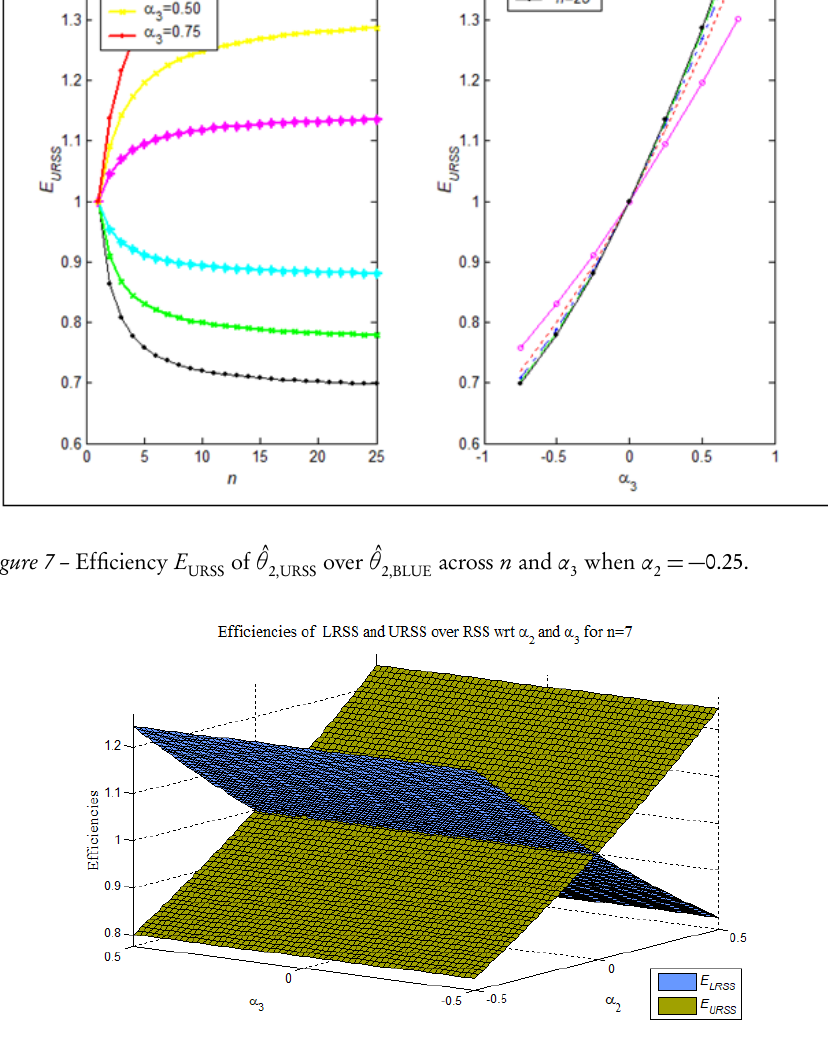
with respect to α 2,BLUE